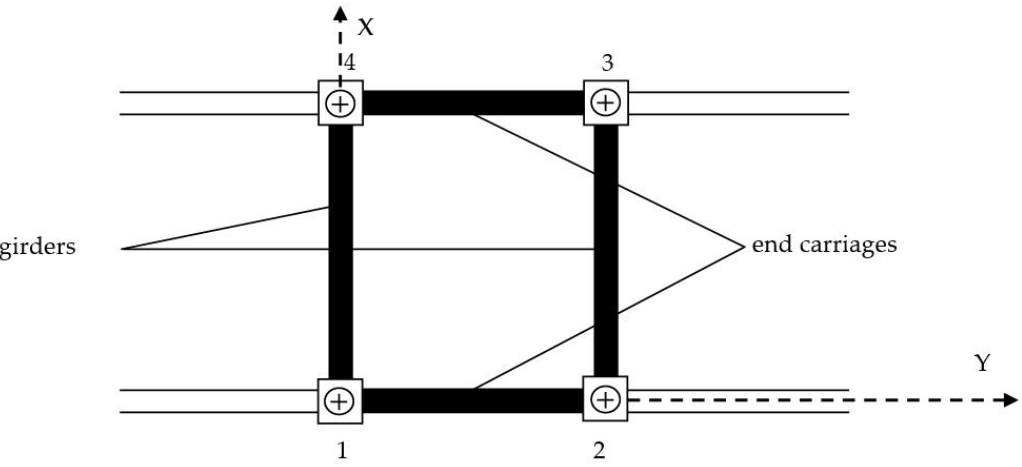
Figure 1. Locations of controlled points of the crane bridge.